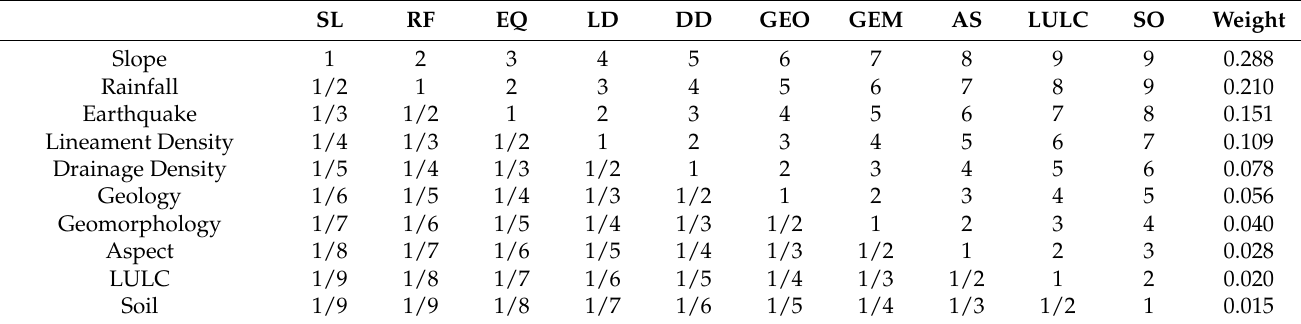
Table 6. The final pair-wise comparison matrix of landslide conditioning